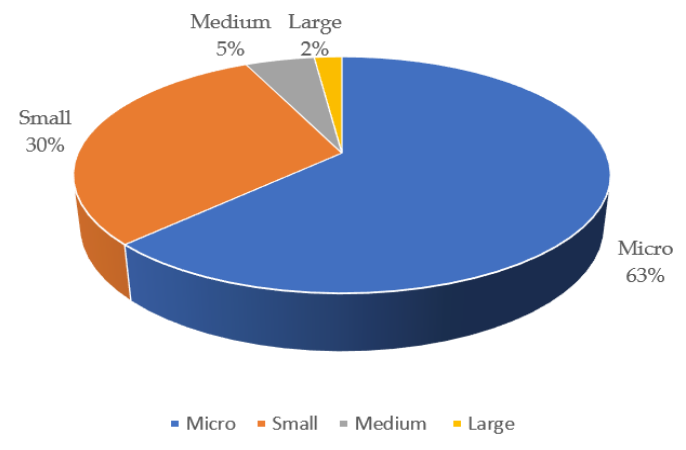
Scheme 1. Size of the sample companies. Source: own